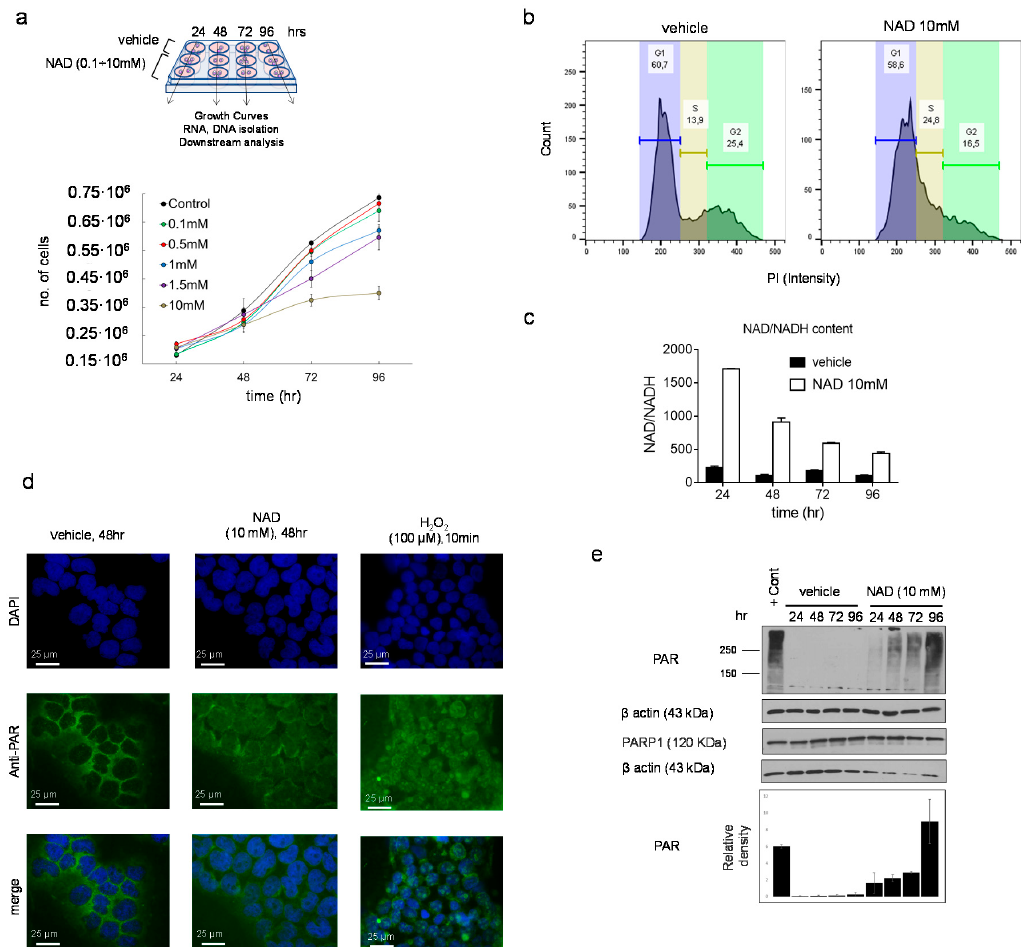
Figure 1. NAD inhibits cancer cell growth in a dose-dependent manner and drives accumulation of intracellular poly ADP-ribose polymers . ( a , upper panel ) Schematic of the experiment. K562 cells were cultured at different concentration of NAD: 0.1, 0.5, 1, 1.5, 10 mM or vehicle. Cell pellets, RNA, and DNA samples were collected at different time points: 24, 48, 72, 96 h. ( a , lower panel ) K562 growth curves in presence of NAD or vehicle. Cells were counted every 24 h for four days. The error bars represent the mean ± standard deviation of four independent experiments ( n = 4). ( b ) Propidium iodide staining of K562 grown in presence of NAD (10 mM) for 72 h and cell cycle analysis by FACS showing a decrease in cells in G2 phase, from 25% to 16%, indicating arrest in the cell division rate. ( c ) The NAD/NADH content measured by colorimetric assay. The absorbance was measured at 450 nm every 24 h from the addition of NAD (10 mM) to the cell culture media. The NAD ratio was calculated according to the manufacturer’s instructions (BioVision). ( d ) Immunofluorescence of PARs in K562 supplemented with NAD (10 mM) or vehicle after 24 h. A positive control is shown in the right column and was obtained growing K562 in presence of 100 µM of H 2 O 2 for 10 min. ( e ) PAR and PARP1 protein levels in K562 cells treated with NAD. The immunoblot band densities is measured using ImageJ and normalized by β -Actin.